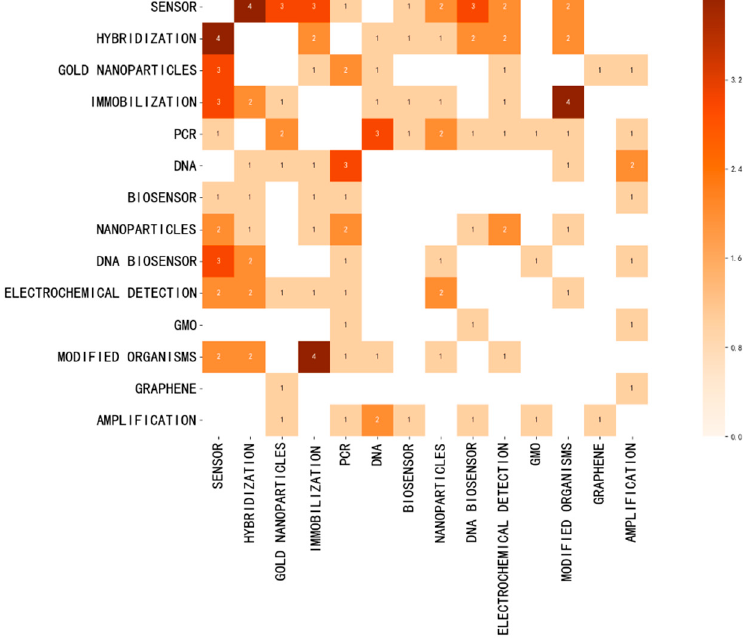
Figure 9. Keywords confusion matrix for electrochemical techniques for the detection and analysis of GM crops.